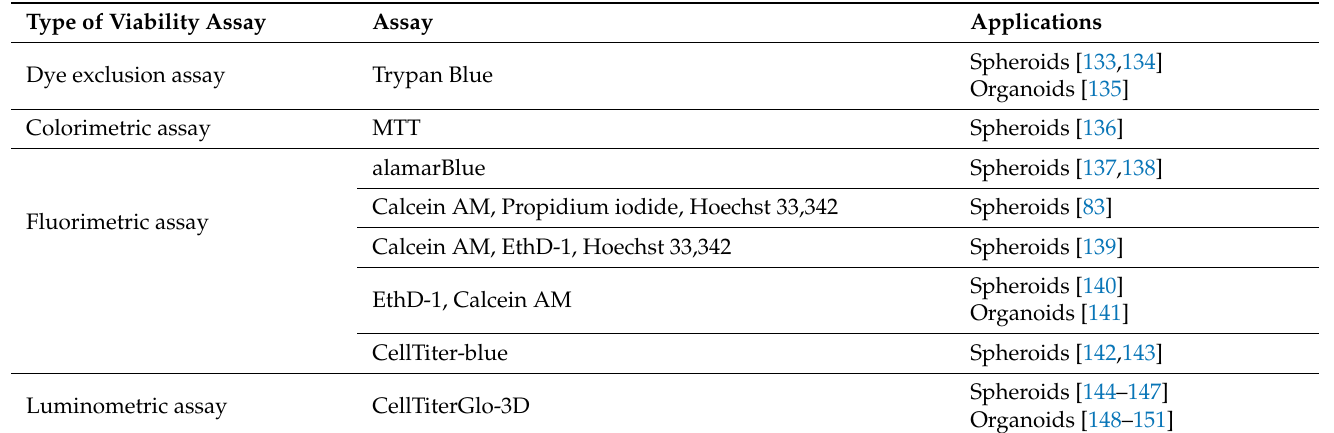
Table 4. Viability assays commonly applied in spheroid and organoid